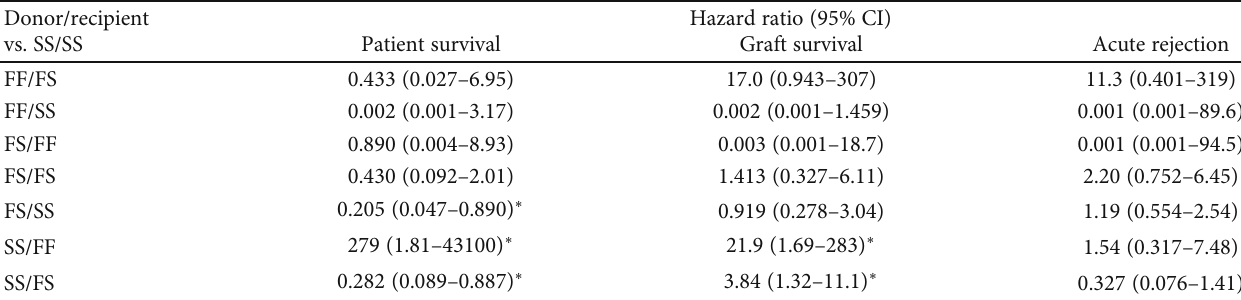
Table 3: Cox proportional hazards-derived hazard ratios for patient survival, graft survival, and acute rejection in donor/recipient combinations versus the SS/SS reference